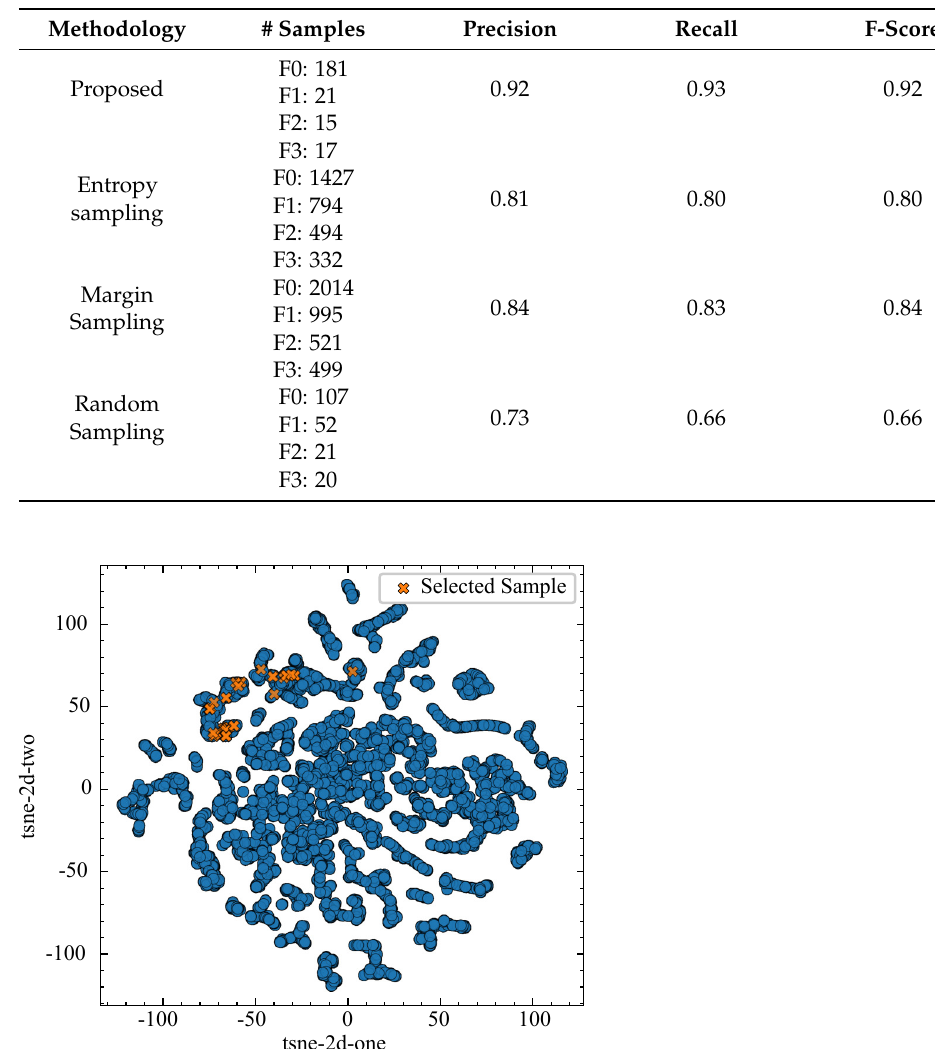
Table 2. Comparison between the proposed approach and different uncertainty sampling techniques.